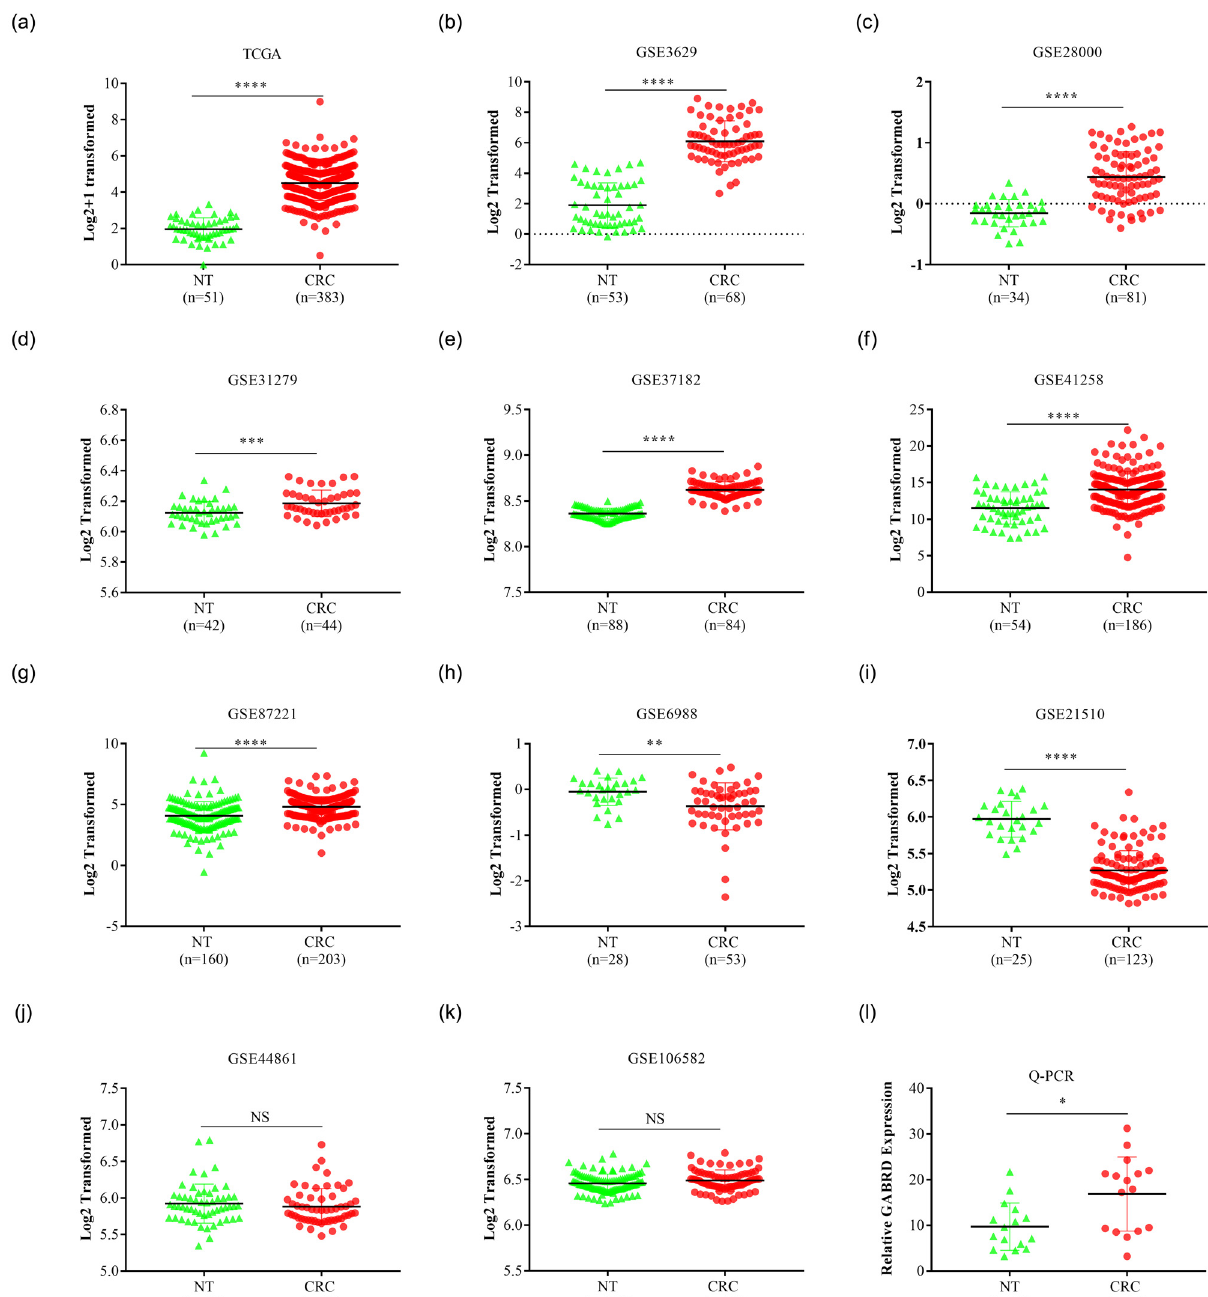
Figure 1: GABRD transcription was increased in CRCs. Expression of GABRD was compared between CRCs and adjacent NTs using transcriptomic data from one combined TCGA - COAD and READ dataset and 10 datasets in GEO. The results demonstrated that the GABRD expression was signi fi cantly increased in seven datasets ( a – g ) , decreased in two datasets ( h – i ) , and similar in two datasets ( j – k ) in CRCs compared to that in NTs. Sixteen paired CRCs and NTs from clinically resected samples were used to validate results from the transcriptomic datasets using q - PCR ( l ) . Abbreviations: CRC, colorectal cancer; GABRD, gamma - aminobutyric acid type A receptor subunit delta; GEO, gene expression omnibus; NS, not signi fi cant; NT, adjacent normal tissue; q - PCR, quantitative polymerase chain reaction; TCGA - COAD and READ, the cancer genome atlas colon adenocarcinoma and rectal adenocarcinoma. * p < 0.05, ** p < 0.01, *** p < 0.001, **** p <